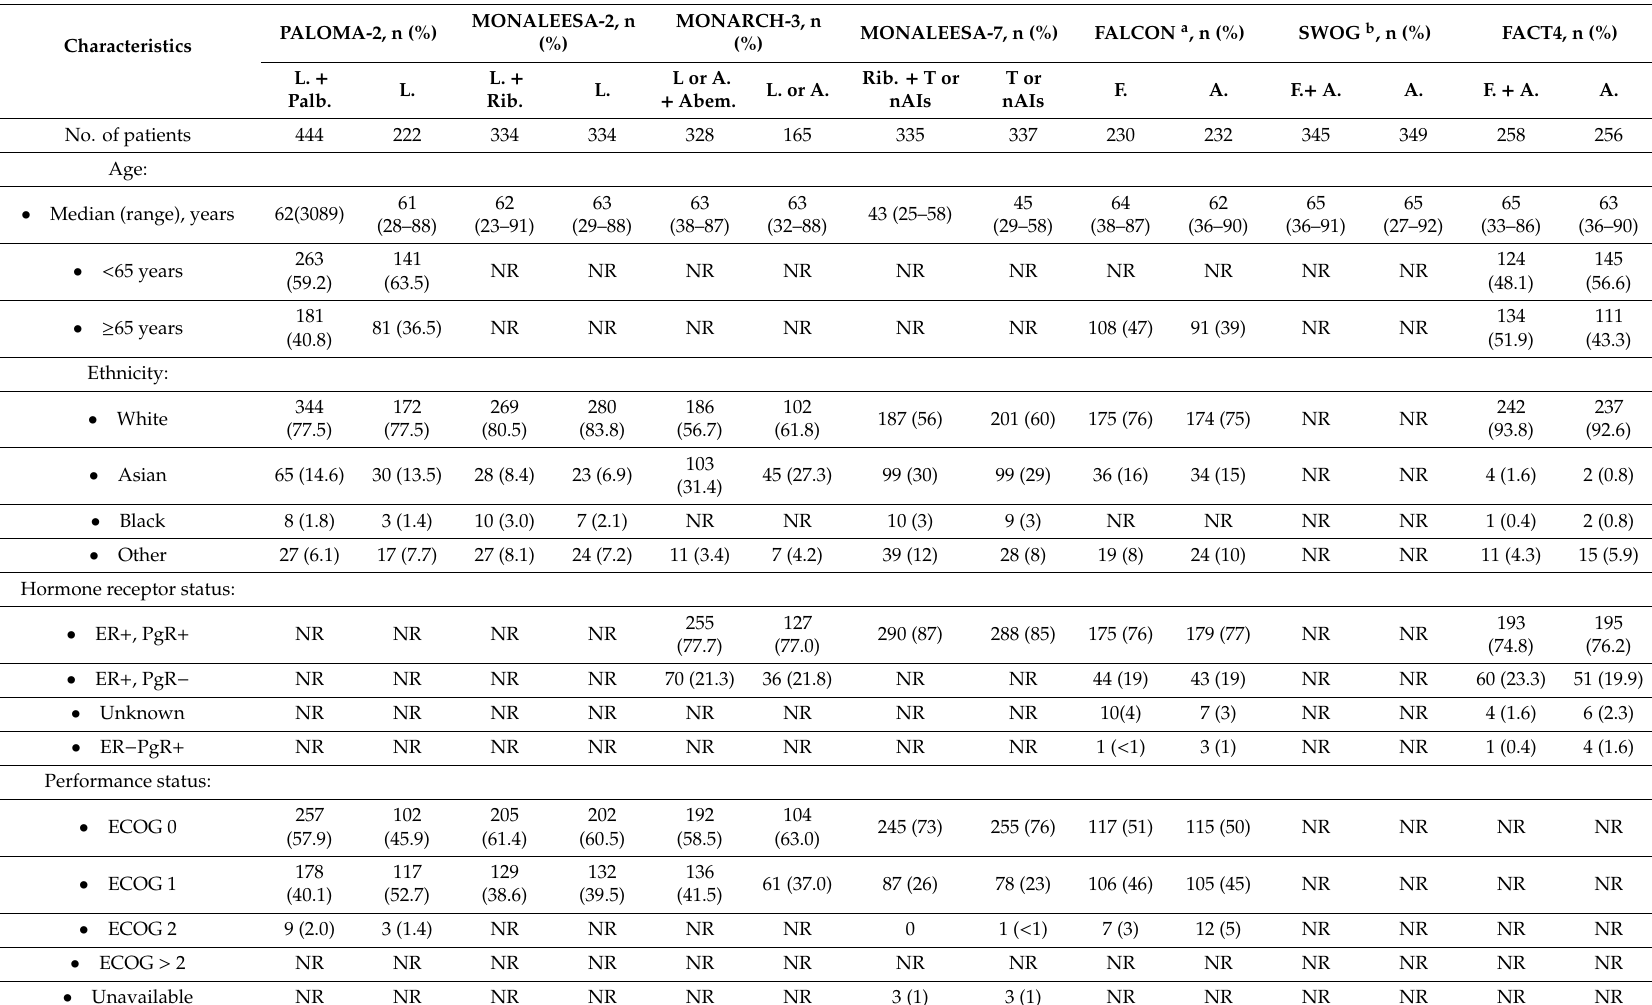
Table 3. Main characteristics of the patients included in the randomized trials evaluated for the present network meta-analysis.